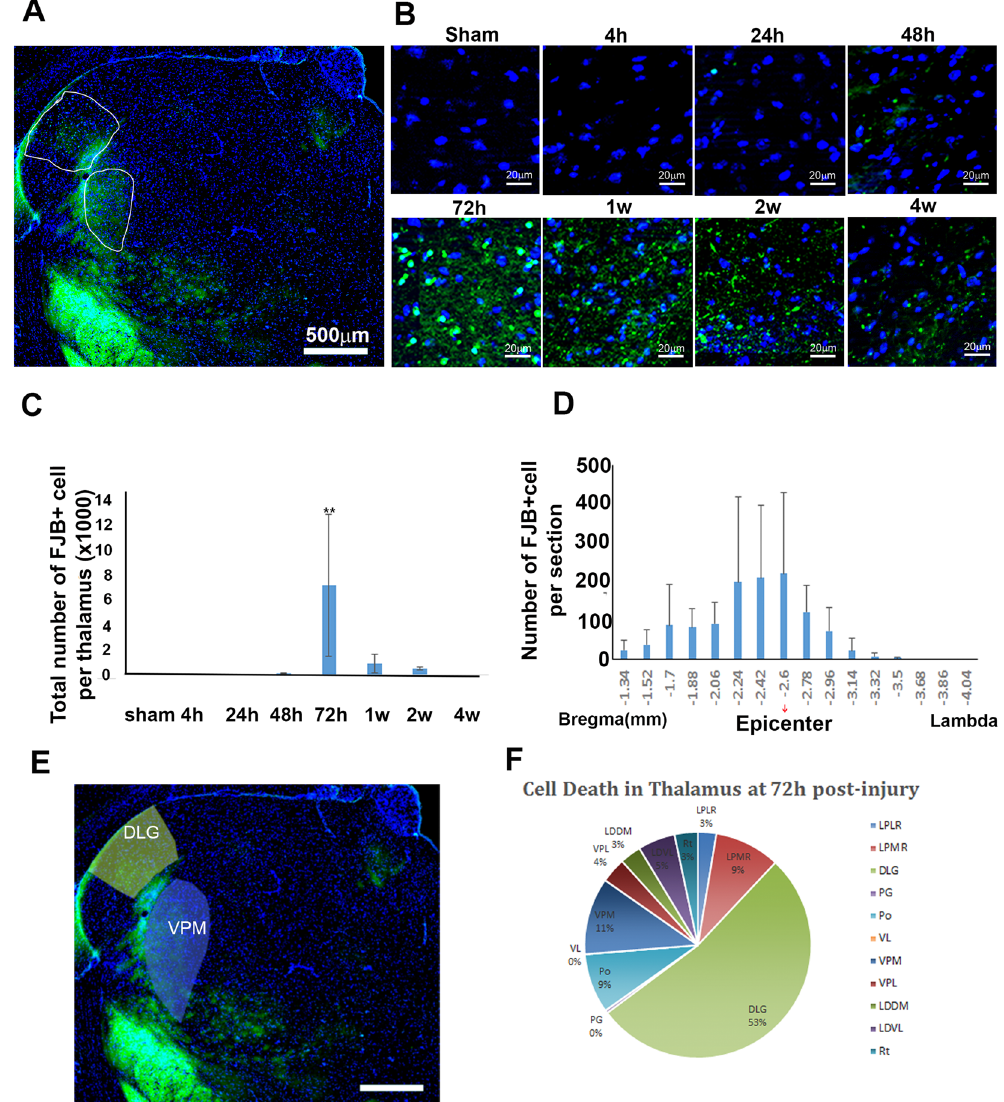
Figure 4. Temporal and spatial patterns of neuronal death in thalamus after TBI. ( A ) Fluoro-Jade B staining (green) showed the neuronal death in thalamus after injury. ( B ) The temporal pattern of neuronal death in thalamus after injury. ( C ) Quantification of FJB stained cells in thalamus (n = 4, ** p < 0.01). ( D ) The rostral- caudal distribution of FJB-positive cells in ipsilateral thalamus at post-injury 72 h. ( E ) The regions where FJB- positive cells accumulated. ( F ) Quantification of FJB stained cells in different nuclei. LPMR: lateral posterior thalamic nucleus, mediorostral part; LPLR: lateral posterior thalamic nucleus, laterorostral part; DLG: dorsal lateral geniculate nucleus; PG: pregeniculate nucleus; Po: posterior thalamic nuclear group; VL: ventralateral thalamic nucleus; VPM: ventral posteromedial thalamic nucleus; VPL: ventral posterolateral thalamic nucleus; LDDM: laterodorsal thalamic nucleus, dorsalmedial part; LDVL: laterodorsal thalamic nucleus, ventrolateral part; Rt: reticular thalamic